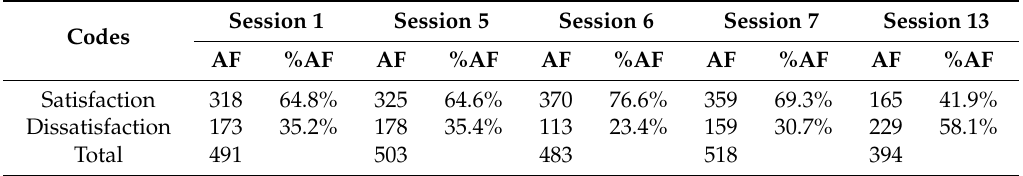
Table 2. Perception of gymnastics learning, according to